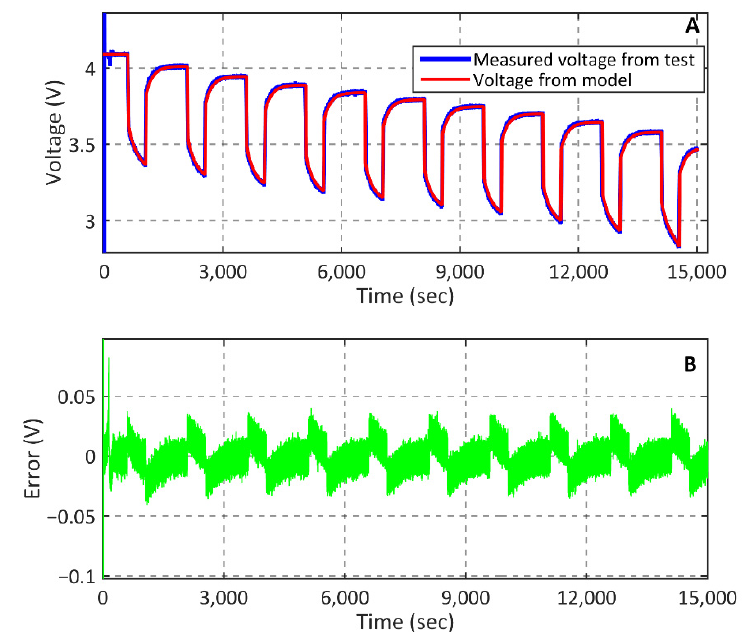
Figure 6. ( A ) True and model voltages, and ( B ) modelling error.